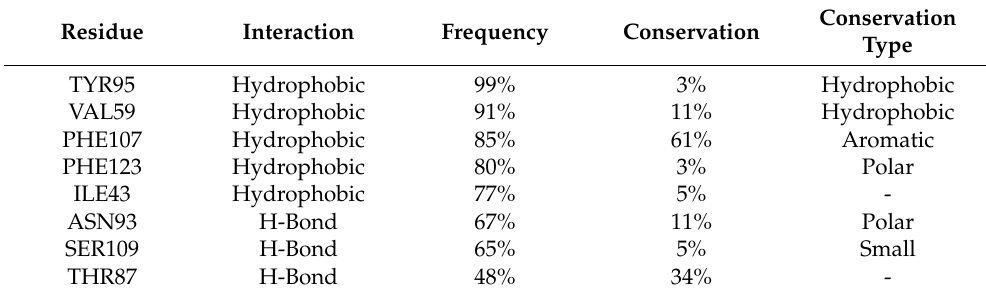
Figure 5. ( A ) Binding pocket residues of mOBP5, colored according to their frequency of contact. The color scale ranges from red, as the maximum frequency, to blue, as the minimum frequency. Only the sidechain for each amino acid residue is represented, and the alpha carbon appears as a sphere. ( B ) Evaluation of the performance of the docking protocol in terms of the ranking of odorant to mOBP5. Dots in green and red account for binders and nonbinders, respectively. The dotted line represents precision for each rank defined as the threshold. ( C ) Linear regression analysis of binding affinity ( K d ) using docking score, volume, and SASA as descriptors. The dotted red line defines the confusion matrix with False Positive (FP), True Positive (TP), False Negative (FN), and True Negative (TN). Table 1. Main residues in the binding site. The frequency is calculated using the ratio of contact between the residue and the ligand for all poses obtained for the agonists (16 binders). Conservation was calculated as the proportion of all homologous sequences containing this residue after